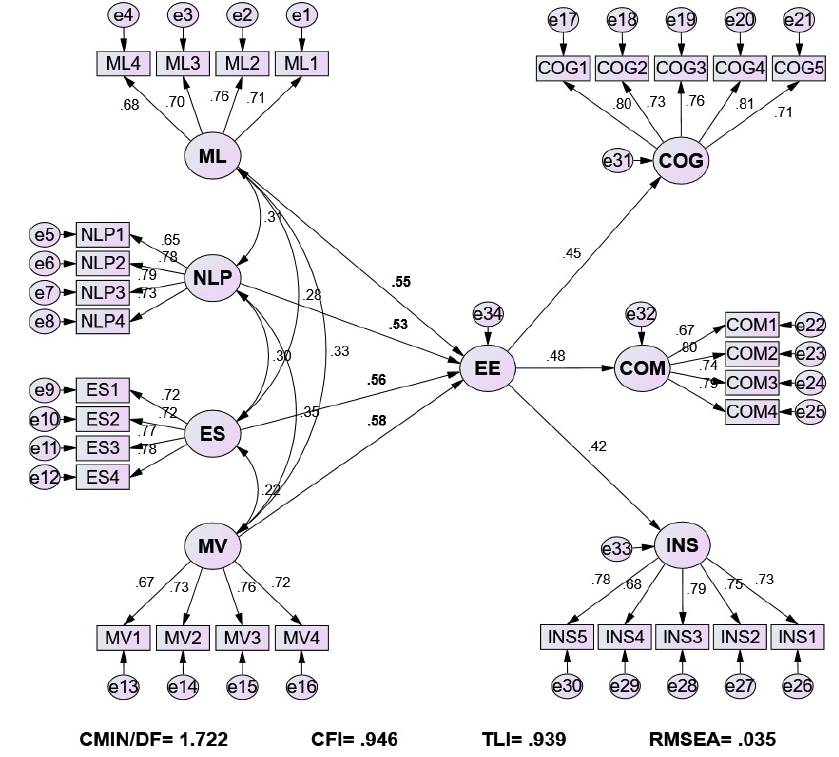
Fig. 3. SEM for the impact of artificial intelligence on entrepreneurship